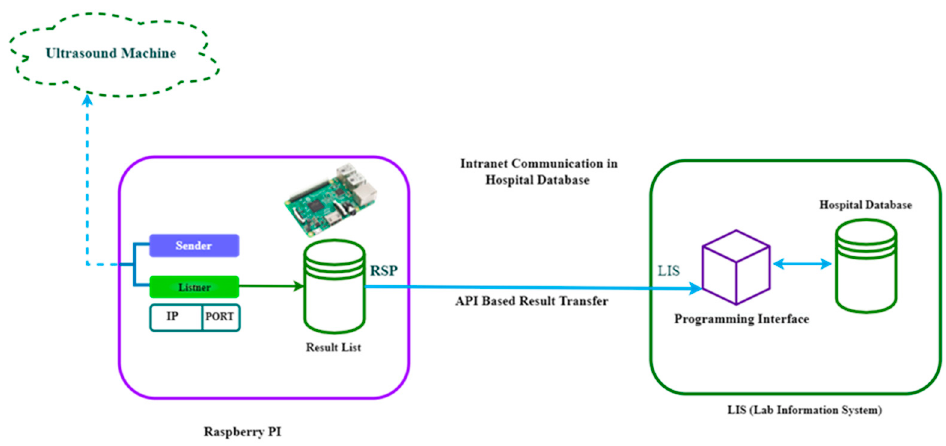
Figure 6. RSPI3 to LIS result data transfer.